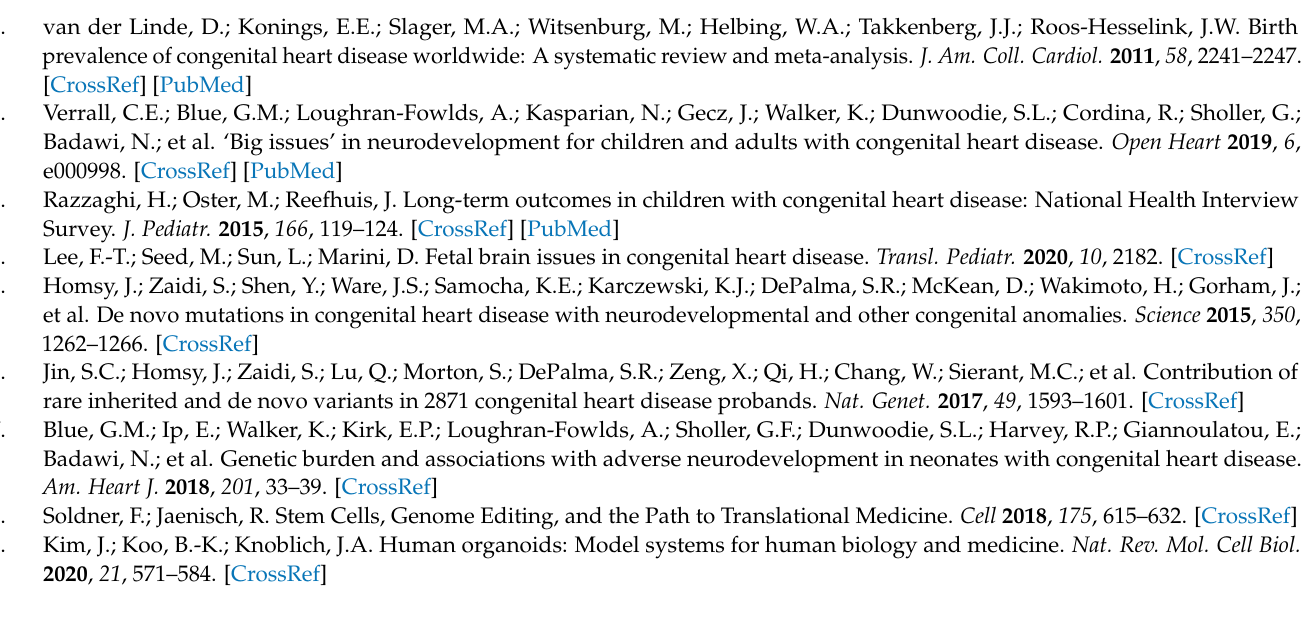
Table S2: Total input NDD genes. Table S3: Total input CHD and NDD genes. Table S4: GO terms of CHD genes (Biological Process dataset). Table S5: GO terms of NDD genes (Biological Process dataset). Table S6: GO terms of CHD and NDD genes (Biological Process dataset). Table S7: GO terms related with developmental signaling pathways (Biological Process dataset). Table S8: GO terms related with epigenetic regulation (Biological Process